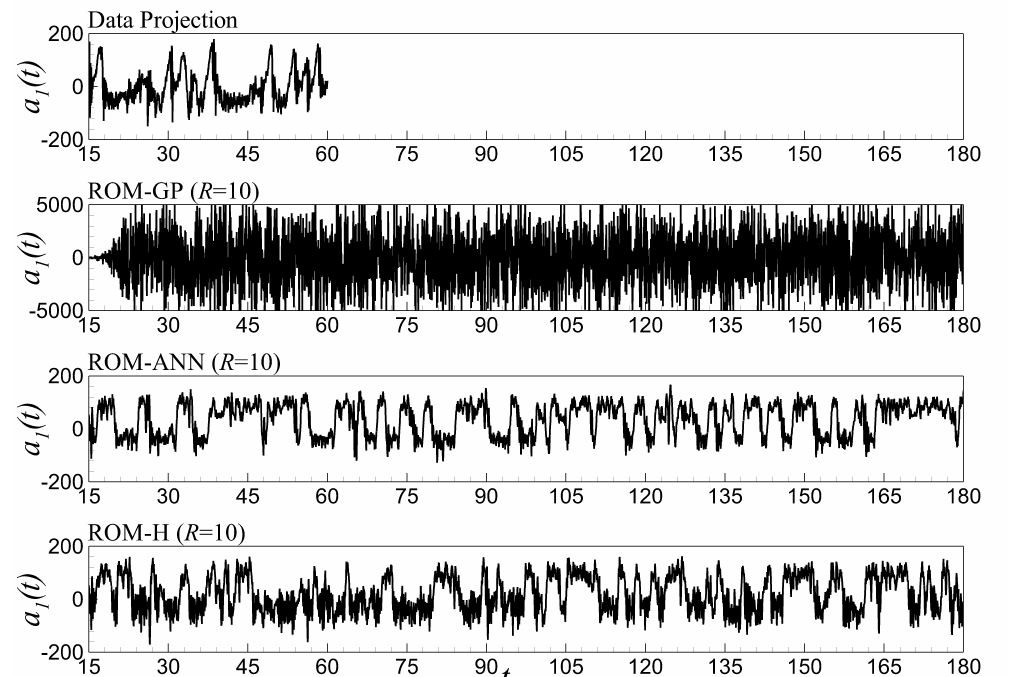
Figure 22. Forecasting of temporal mode evolution of a 1 ( t ) for Re = 100. Note that all ROMs are trained by the data snapshots obtained between t = 15 and t = 60. Although the ROM-GP approach provides reasonable (physical) results at the beginning (i.e., t < 18), the error then is amplified exponentially.